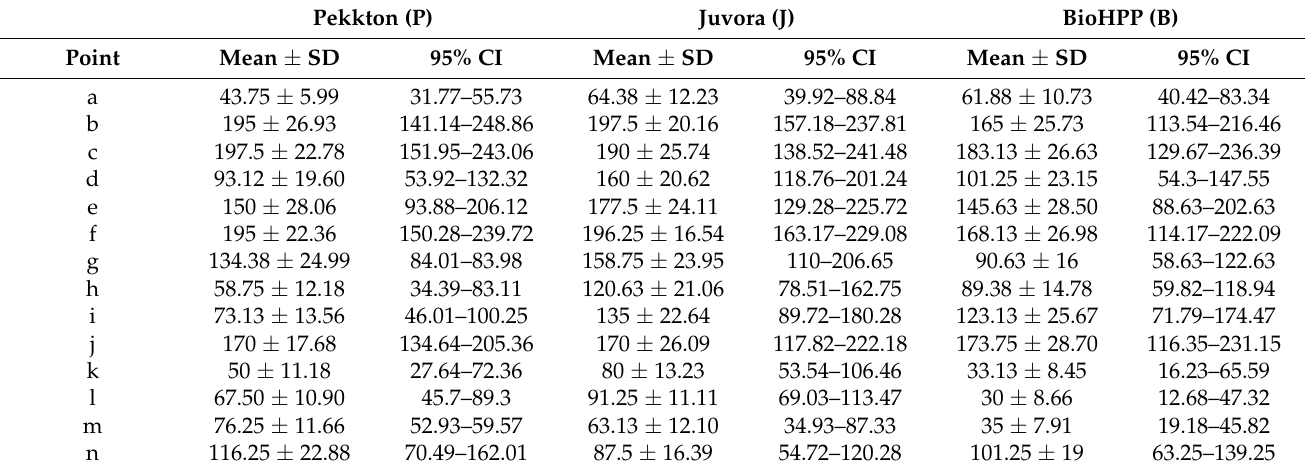
Table 2. Average of linear measurements with standard deviation (SD) at reference points (a ↔ n); CI = confidence interval (lower–upper bound) ( n = 8).